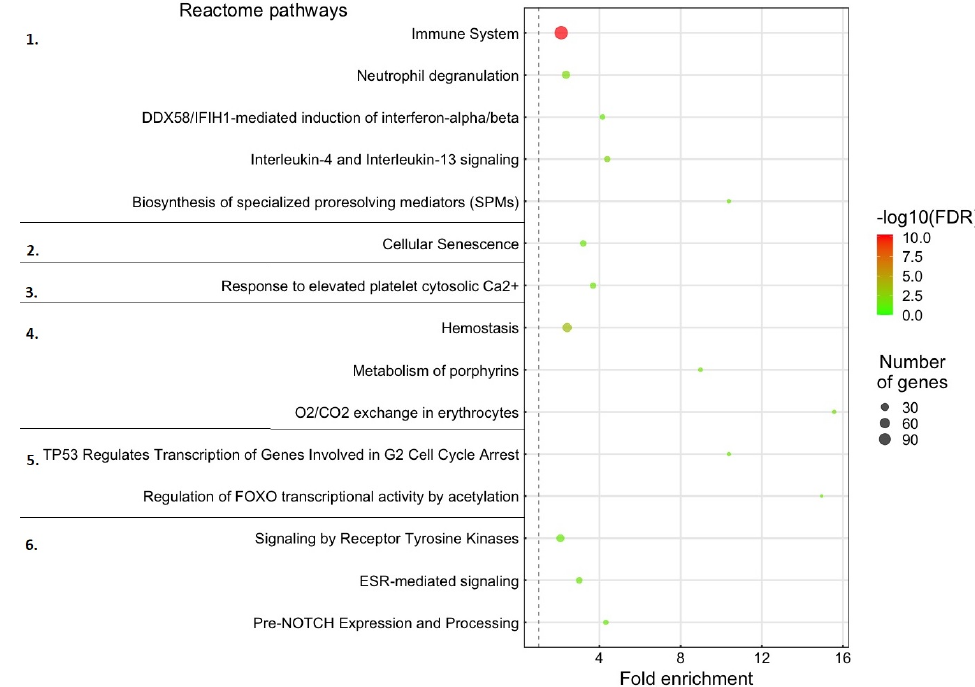
Figure 3. Enriched gene pathways associated with tDE-mRNA genes in head-kidney. The dot size indicates the number of tDE-mRNA genes associated with the process and the dot color indicates the significance of the enrichment ( − log10 FDR-corrected p -values). The dot’s position on the Y-axis indicates fold-enrichment compared to the expected occurrence for a random set of genes of that size. The Reactome pathways were subdivided into the following categories indicated by the numbers on the far left: 1. Immune system. 2. Response to Stress. 3. Platelet Activation. 4. Hemostasis. 5. Cell Cycle Control. 6. Receptor Signaling.